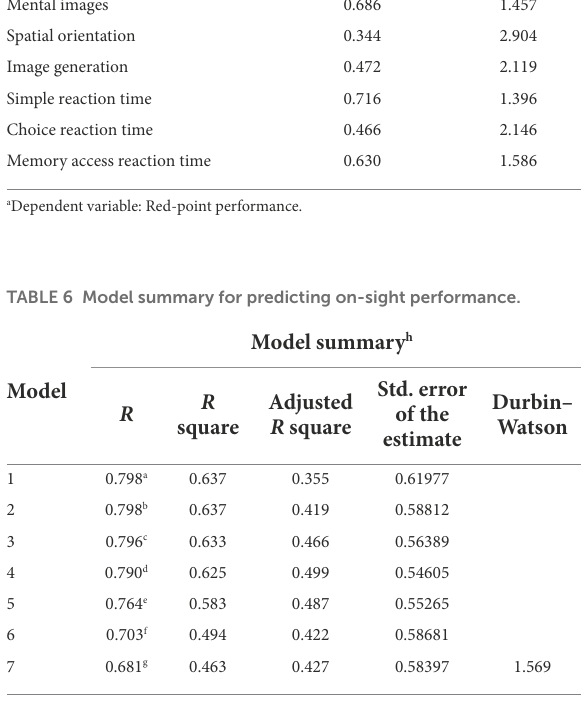
TABLE 8 Coefficients for predicting on-sight performance.